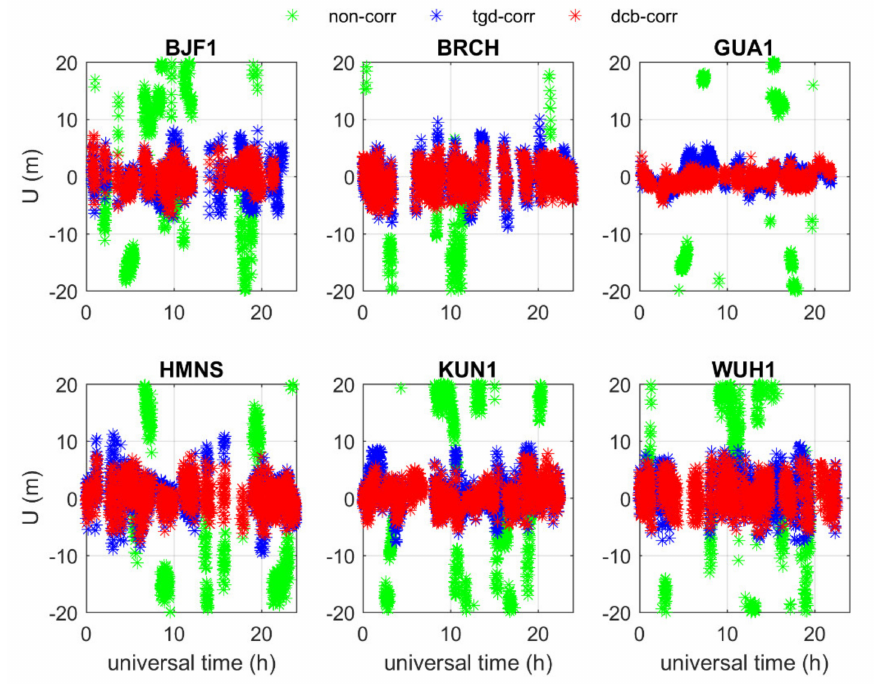
Figure 18. Vertical positioning error scatters with and without TGD or DCB correction of B1C/B2a SPP at six